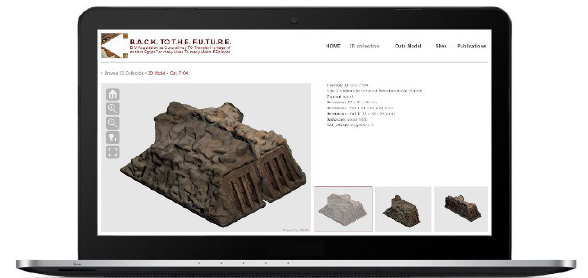
Figure 15. Interactive Web presentation of high-resolution 3D